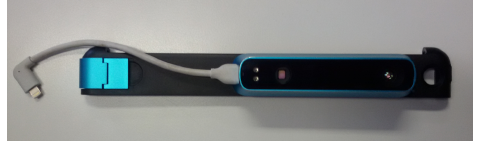
Figure 1: The Structure Sensor by